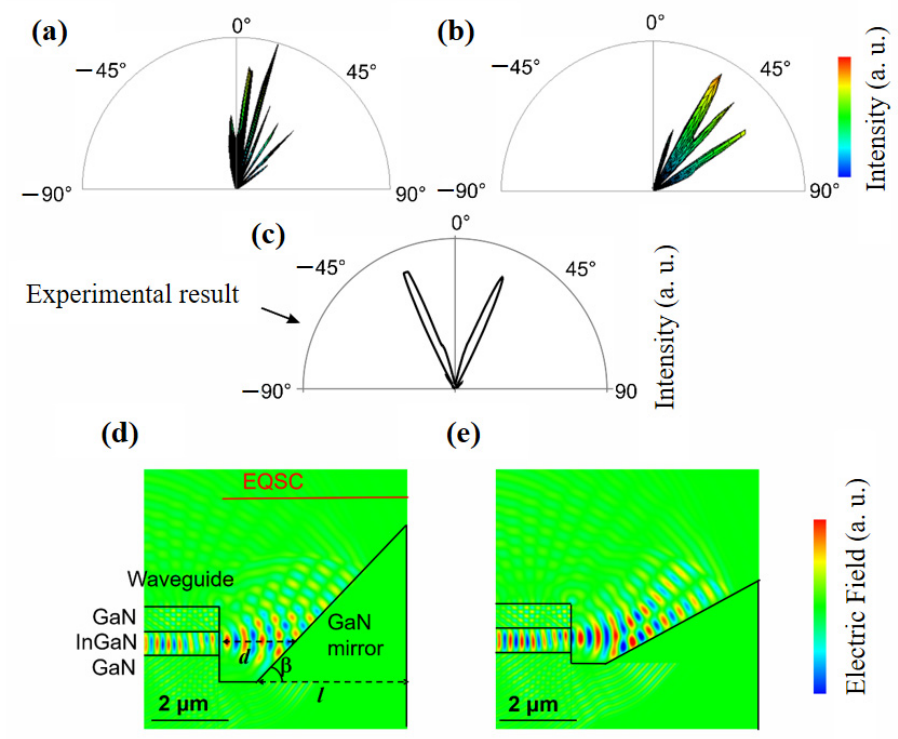
Figure 14. ( a , b ) Calculated radiation patterns and ( d , e ) electric field distribution for the combination of the InGaN/GaN waveguide and GaN mirror. The cases of mirror angles of b = 45 ◦ and 30 ◦ are simulated. ( c ) Measured far-field radiation pattern (the same data as shown in Figure 13a) presents in an analogical way to the results of calculations.